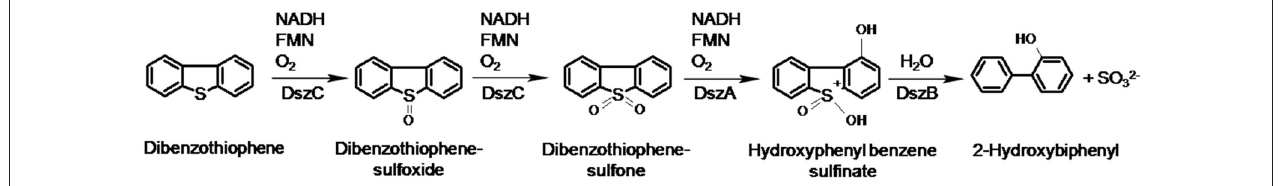
FIGURE 1 | The 4S pathway of non-destructive biodesulfurization of dibenzothiophene (Gallagher et al.,